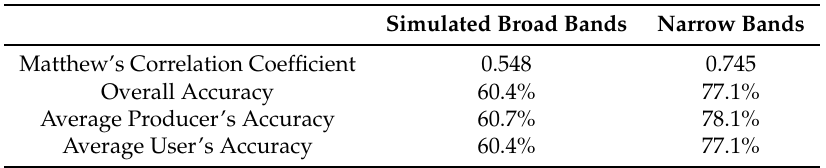
Table 6. A comparison of discrimination accuracies and reliability using simulated WorldView2 broad bands, and narrow bands from hyperspectral